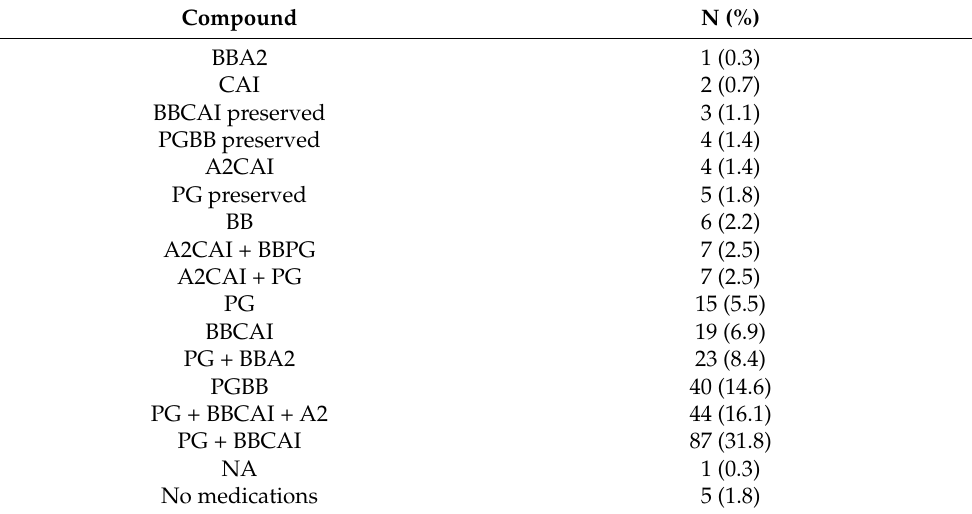
Table 5. Treatment regimens of the patients enrolled in the XEN-GTR (no. (%)). Compound